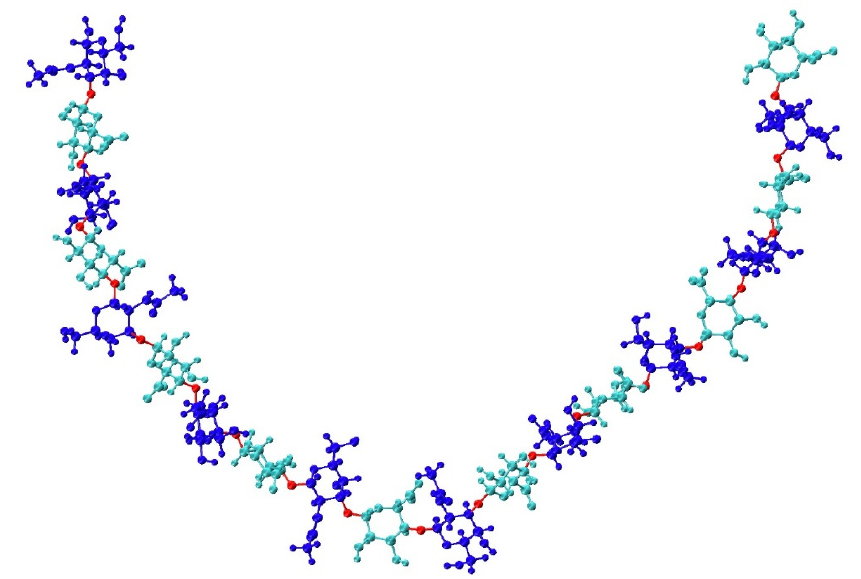
Figure 1. Compact non-sulfated chondroitin 20-mer conformation arising from flexible glycosidic linkages (red) between monosaccharide rings (GalNAc in blue and GlcA in cyan). The molecular graphics throughout are produced with the VMD program [57].